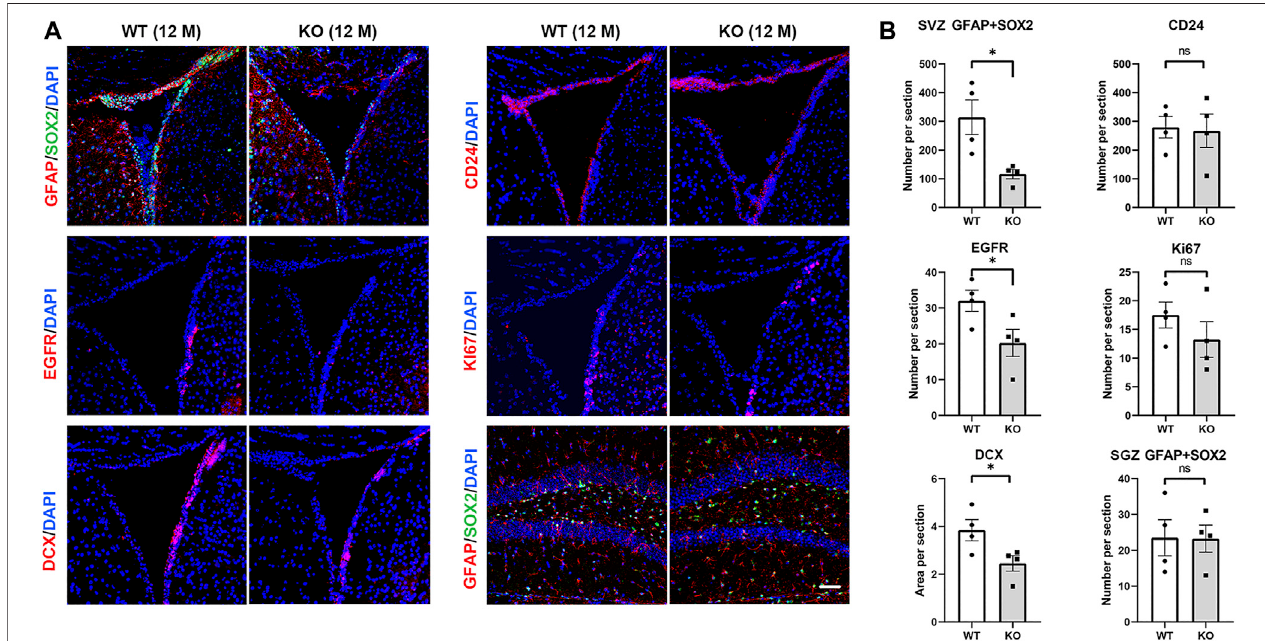
FIGURE5| Ttyh1preventsacceleratedexhaustionoftheelderlyNSCspool. (A) Immuno fl uorescencestainingofbrainsectionsofeldercontrolandTtyh1KOmice at 12-months old (12 M). Sox2 + GFAP + NSCs, EGFR + TAPs, DCX + neuroblasts, Ki67 proliferating cells and CD24 ependymal cells were compared in neurogenic niche between control and Ttyh1 KO mice. (B) Statistics of immuno fl uorescence staining results in A. Scale bar (cid:2) 50 μ m in A. n (cid:2) 4 for all experiments. Data are expressed as mean ± SEM. Statistical signi fi cance was calculated using an unpaired, two-tailed Student ’ s t -test. ( p ) p < 0.05.